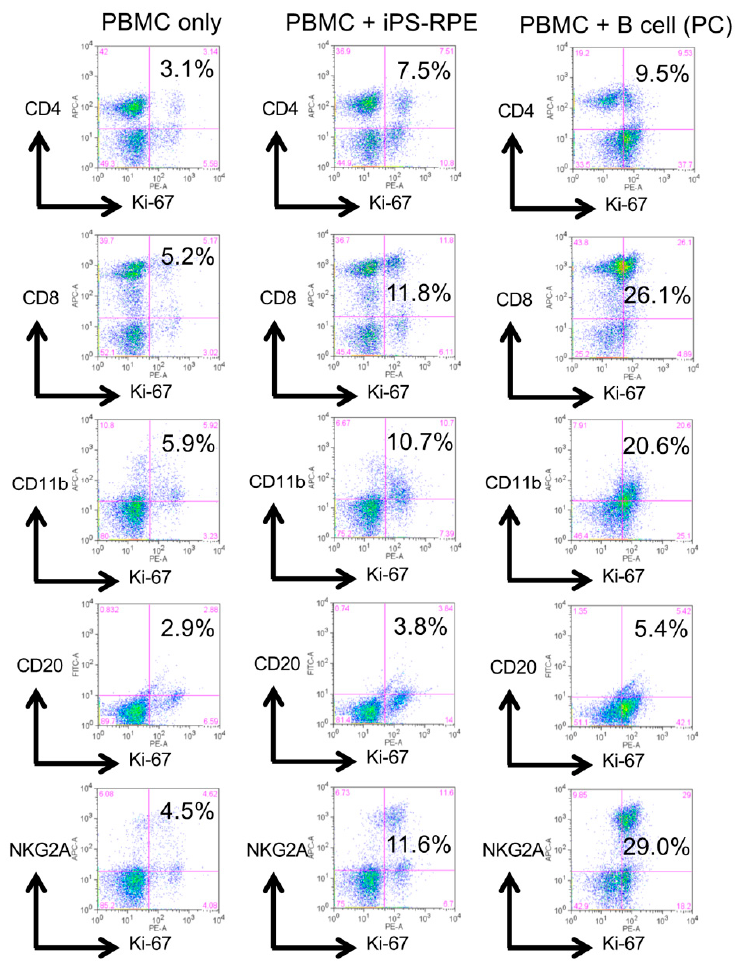
Figure 1. Representative results of LGIR with peripheral blood mononuclear cells (PBMC) from a monkey. PBMCs (2 × 10 6 cells/well) from a healthy monkey HM-1 were cultured with iPSC-RPE cells for 5 days. Before the assay, iPSC-RPE cells were irradiated (20 Gy) and 1 × 10 4 cells were used for a 24-well culture plate. After 5 days of coculture, PBMC were harvested and stained with anti-CD4 (helper T cell-marker), anti-CD8 (cytotoxic T cell-marker), anti-CD11b (monocyte-, macrophage-, NK cell-, and granulocyte-marker), anti-CD20 (B cell-marker), anti-NKG2A (natural killer (NK) group 2 member A; NK cell-marker), and anti-Ki-67 (proliferation marker) antibodies. As a positive control (PC), irradiated allogenic B cells were used. The samples were analyzed by a fluorescence-activated cell sorting (FACS) flow cytometer. Numbers (%) in the scatterplots indicate double-positive cells (e.g., CD4/Ki-67).